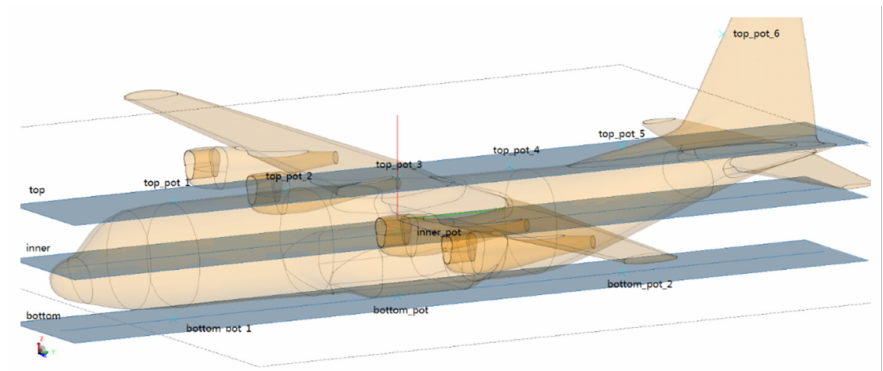
Figure 3. Layers for solving the electric field strength distribution.